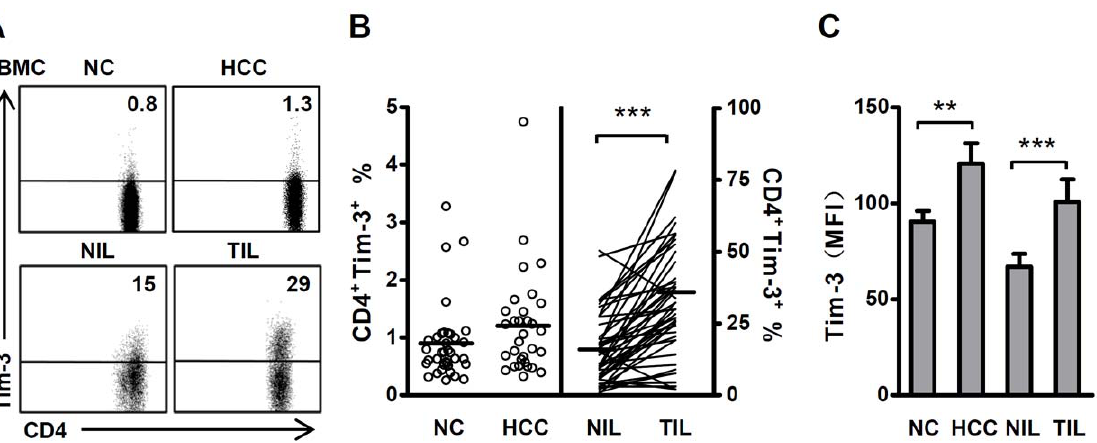
Figure 1. Tim-3 is upregulated on CD4 T cells in HCC tumor tissues. A . Representative FACS analysis of Tim-3 expression in CD4 T cells isolated from the PBMCs of normal healthy controls (NC) and HCC patients (HCC), and nontumor-infiltrating lymphocytes (NILs) and tumor-infiltrating lymphocytes (TILs) from HCC patients. Flow cytometry data are representative of at least 31 samples in each group. B . Statistical analysis of the proportion of Tim-3 + CD4 T cells in NC ( n =36), HCC ( n =31), NILs and TILs ( n =46). Each circle or thin line represents a single case. Horizontal lines indicate the mean of an individual group. C . Mean fluorescence intensity (MFI) for Tim-3 on CD4 + Tim-3 + T cells in each group. NC ( n =36), HCC ( n =31), NILs and TILs ( n =46). Bars indicate the SEM; **, P , 0.01; ***, P , 0.001.